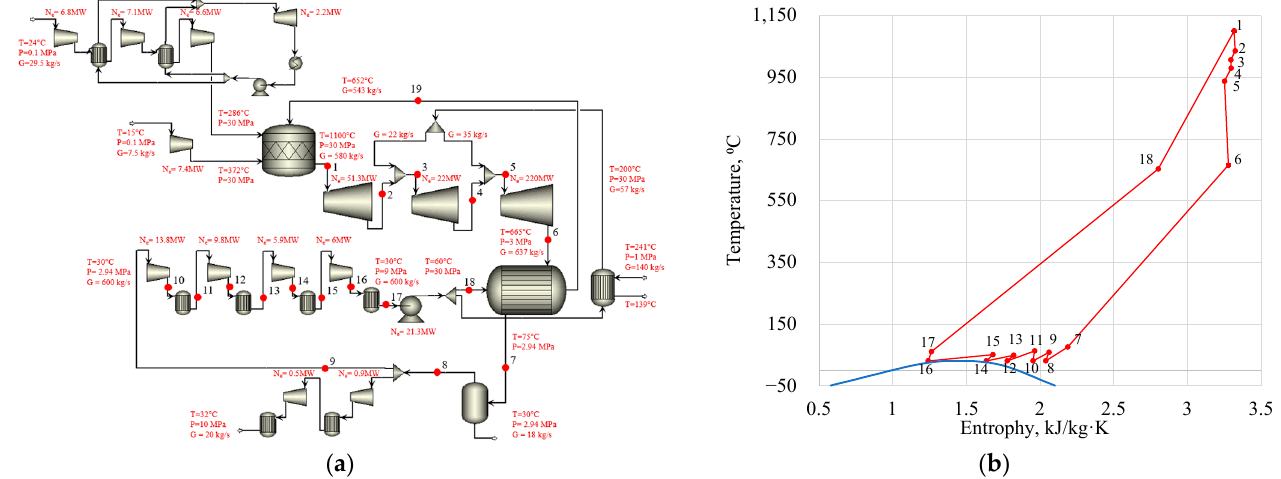
Figure 7. Calculation results of the Allam cycle heat balance: ( a ) parameters in the main units; ( b ) T-S diagram.